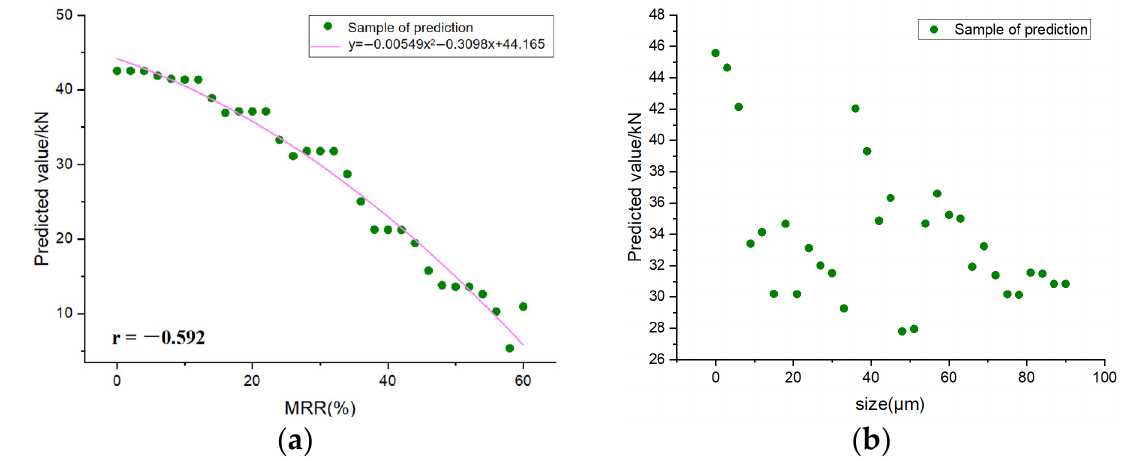
Figure 14. RCP feature sensitivity analysis diagram. ( a ) mass replacement rate; ( b ) size.